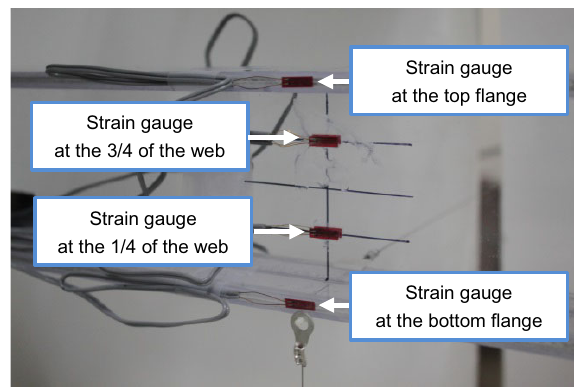
Fig. 6 Strain gauges for the strain